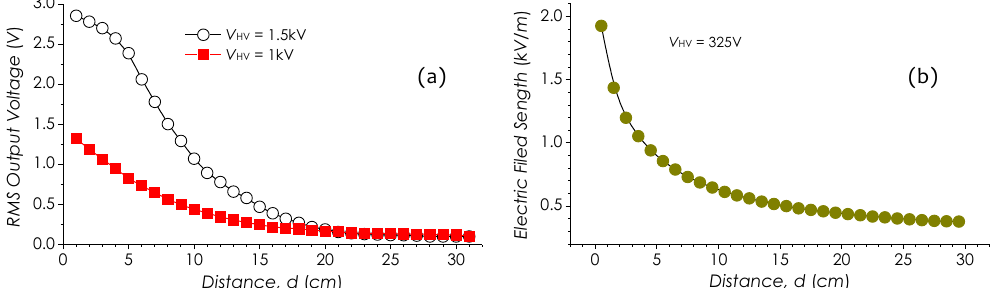
Figure 17. Measurements of field strength around an electrode, with ( a ) our sensor and ( b ) ME-3030B.